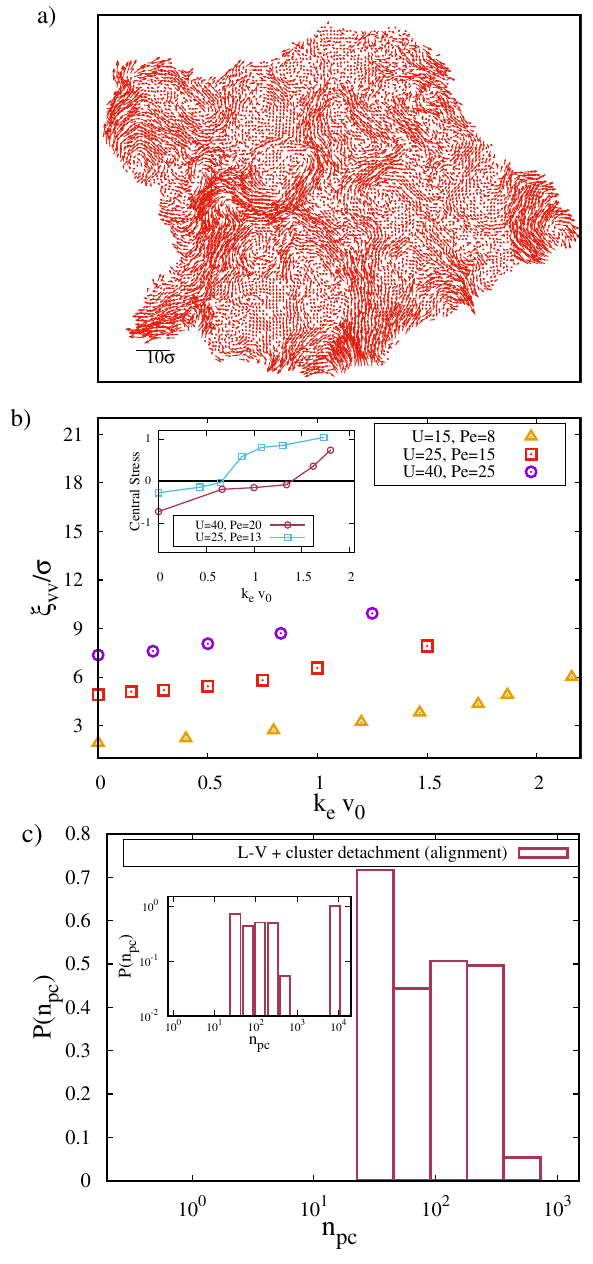
Fig. 5 Dynamics of a cell colony with orientation-velocity alignment interactions. a Velocity fl uctuation fi eld of the full cell colony for U = 40, Pe = 25, and k e v 0 = 1.25 at (cid:1) σ ¼ 0 : 3 σ , which displays prominent swirls in the bulk and fi nger-like structures at the edge. See also Supplementary Fig. 7, and Movies 4 and 5. b Characteristic correlation length ξ vv , extracted from velocity correlation, as a function of alignment strength k e , for different attractive inter- actions U and activities Pe, as indicated, with (cid:1) σ ¼ 0 : 3 σ . The colony is in the fl uid state for k v = 0. Inset: Variation of total central stress as a function of e 0 alignment strength k e , for adhesive strength U = 25,40 ( (cid:1) σ ¼ 0 : 3 σ ). For both data sets, the colony is in the solid state for k e = 0, and transits to a liquid state at k e v 0 ≃ 0.65 and k e v 0 ≃ 1.3 for U = 25 and U = 40, respectively. c Cluster size distribution with velocity alignment ( U = 40, Pe = 28, (cid:1) σ = σ ¼ 0 : 3, and k e v = 1.4, thus in the “ Liquid-Vacuum + Detachement ” 0